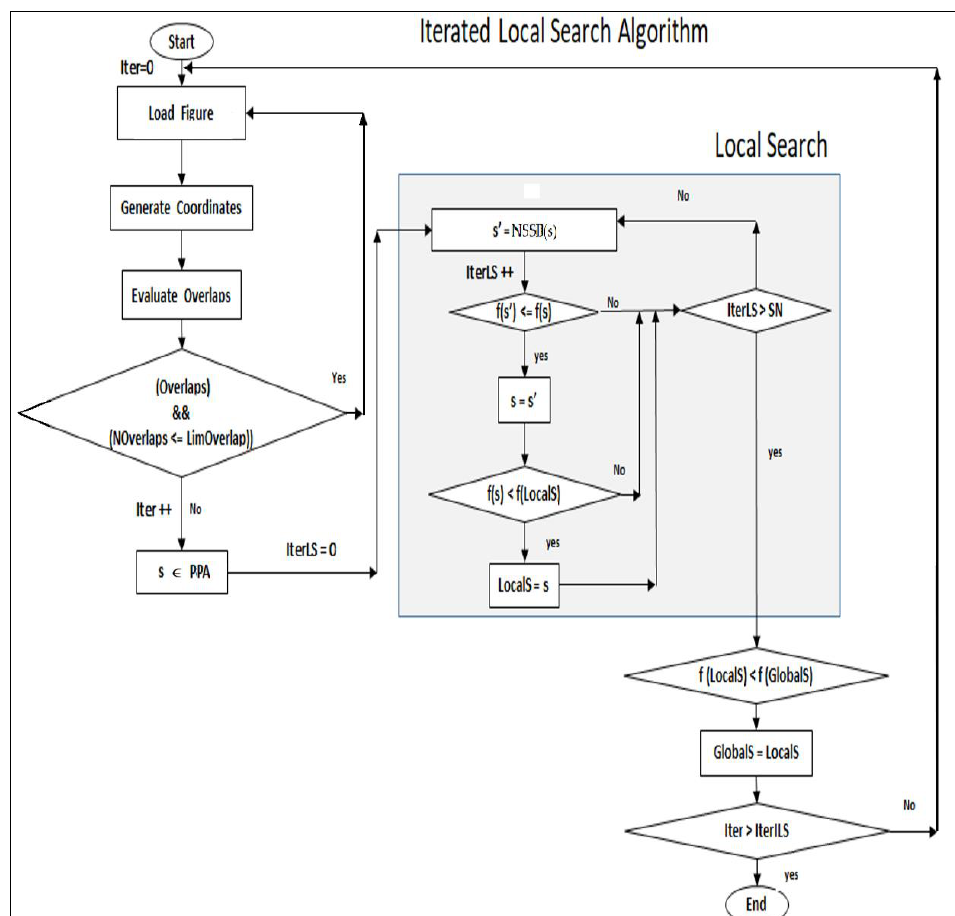
Figure 3. ILS flow diagram to the paper waste optimization problem.